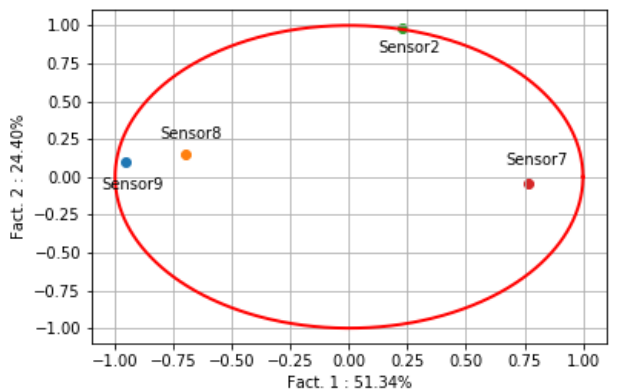
Figure 6. PCA Result of Each Sensor of the Array